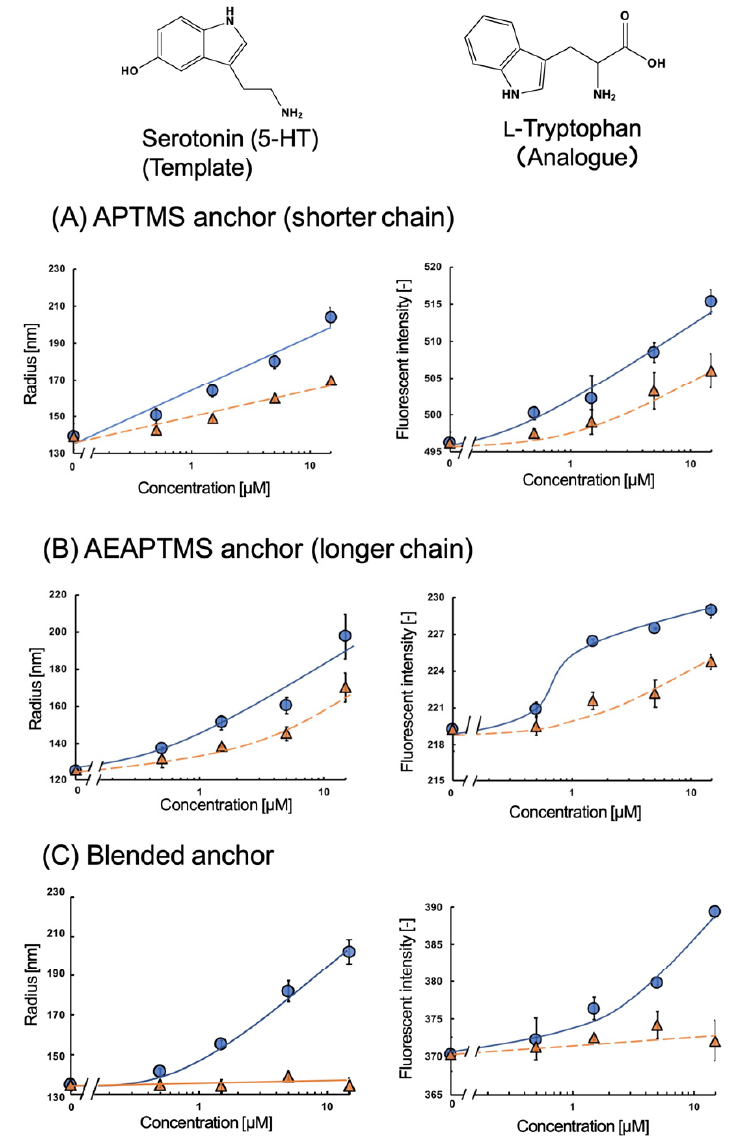
Figure 3. Effect of the 5-HT (circles) and Trp (triangles) on the radius ( left ) and fluorescent intensity ( right ) of the fMIP-NP synthesized with the 5-HT as a template anchored with ( A ) APTMS, ( B ) AEAPTMS, or ( C ) their 1:1 blend in mole.